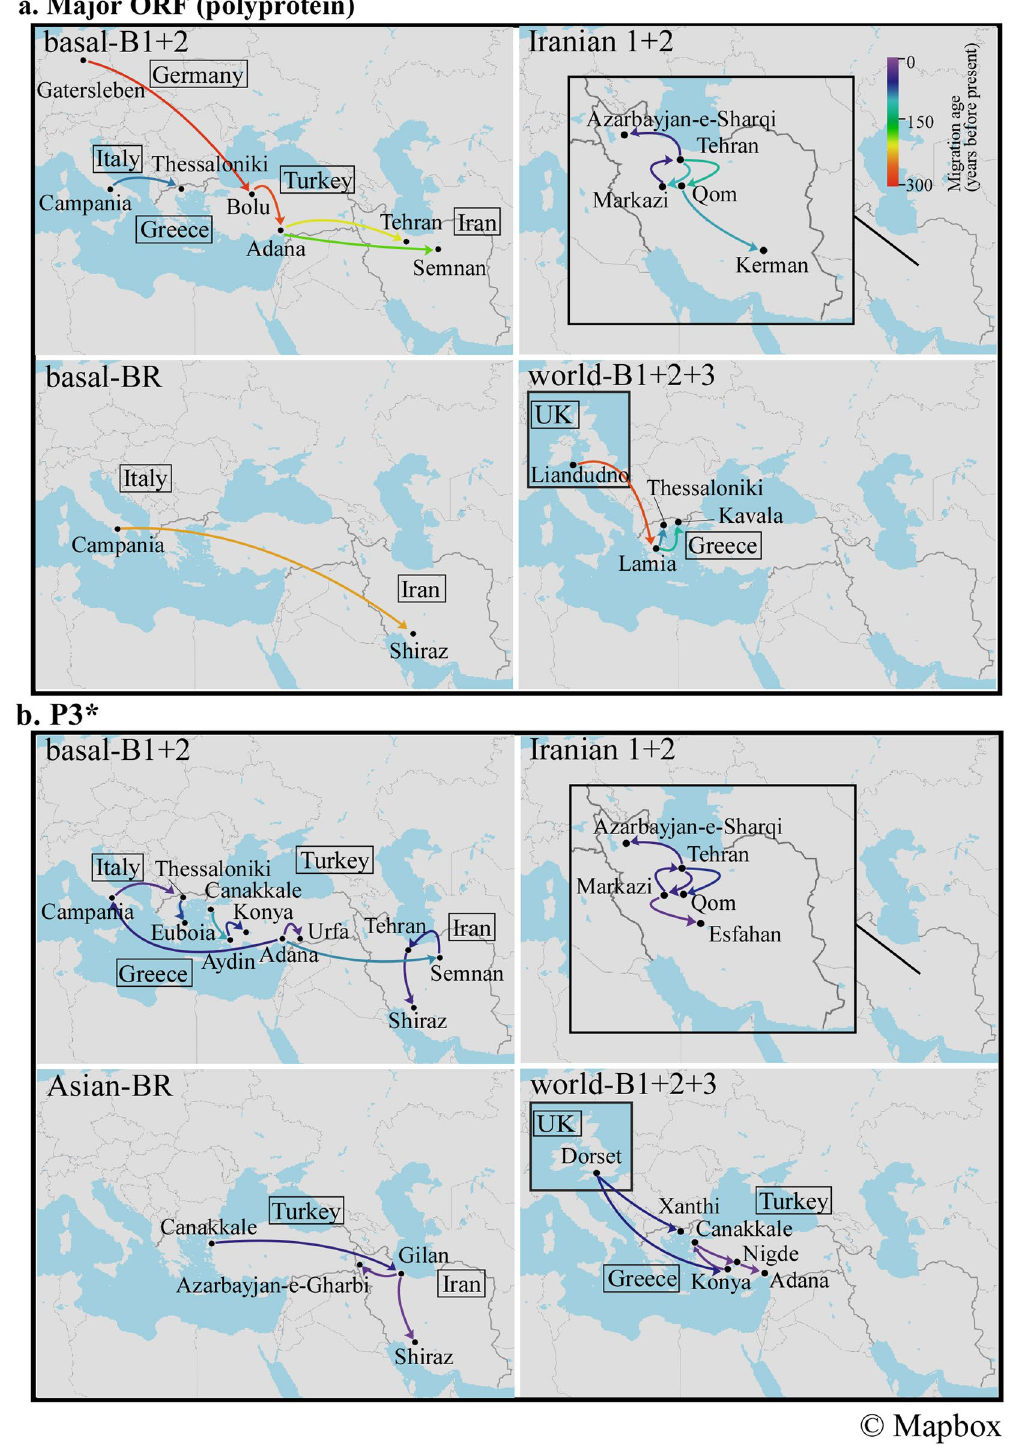
Figure 5. Plausible historical dissemination pathways of turnip mosaic virus inferred using the major open reading frame (ORF) and partial protein 3 (P3 * ) sequences using non-recombinant sequences. Details of the regions of (a) major ORF and (b) P3 * are given in the Methods. Dissemination routes are only shown for the Middle East, and only when supported by a Bayes factor > 10. The dissemination pathways for basal-B1 + 2, Iranian 1 + 2, basal-BR, Asian-BR and world-B1 + 2 + 3 group (subgroup) isolates are shown (https://www.